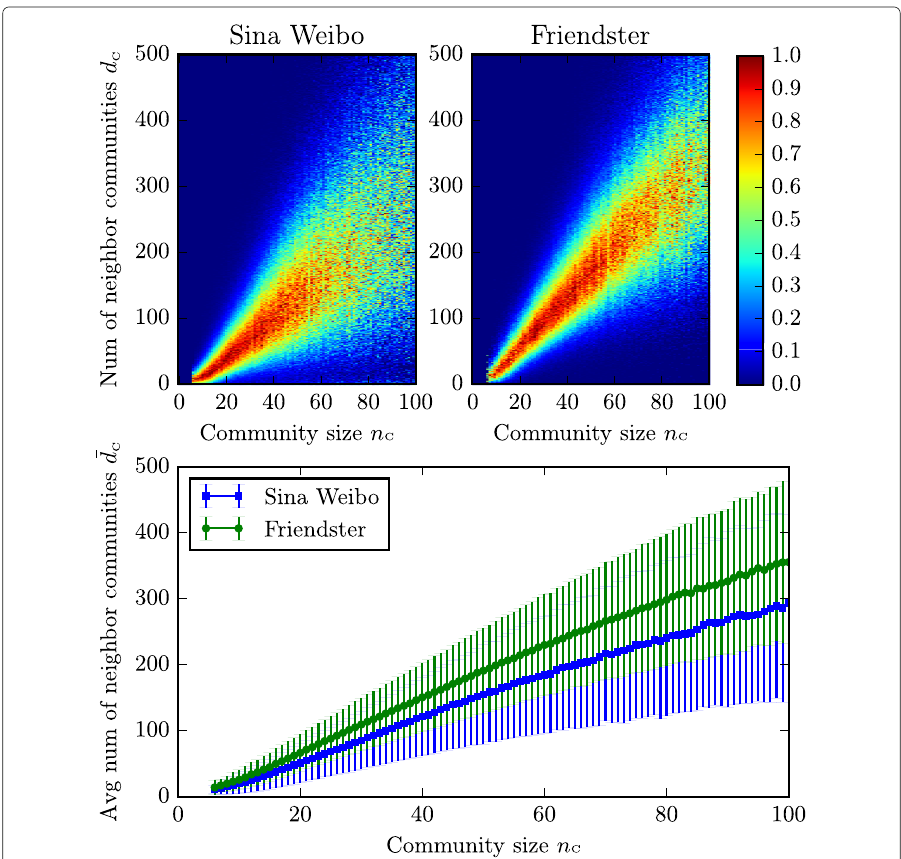
Fig. 3 The relationship between a community’s size and the number of its neighbor communities. Data are shown for community sizes from 6 to 100. The values in each vertical cut of the histograms are rescaled by mapping the highest value to unity. The bottom figure shows the averaged values and their standard deviations